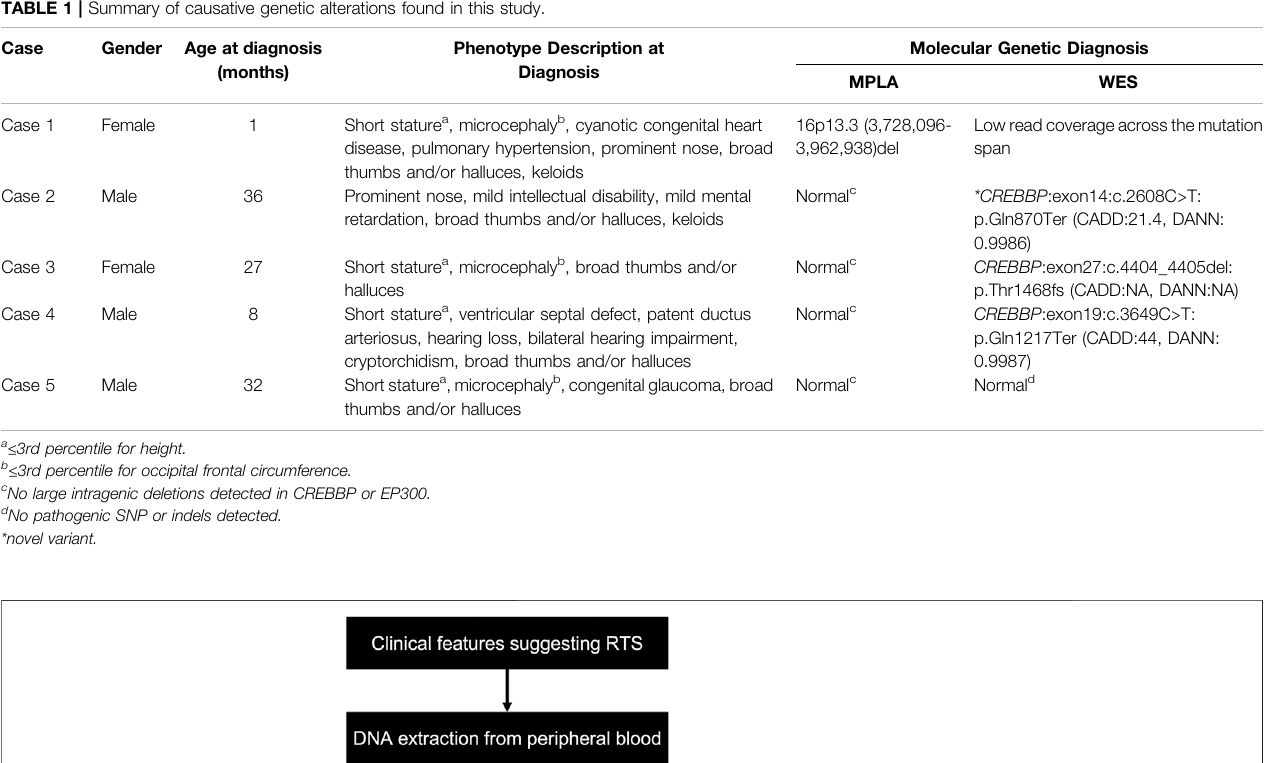
Frontiers in Genetics |